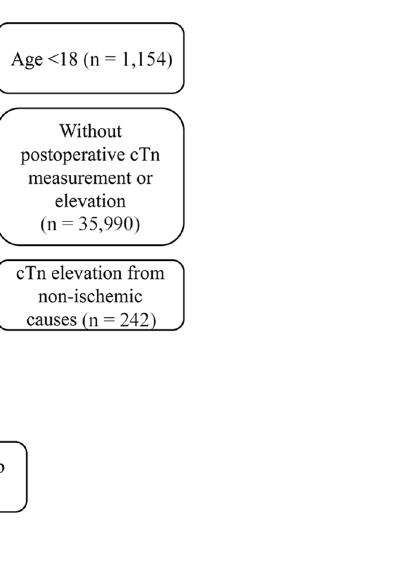
Figure 1. Flowchart of study